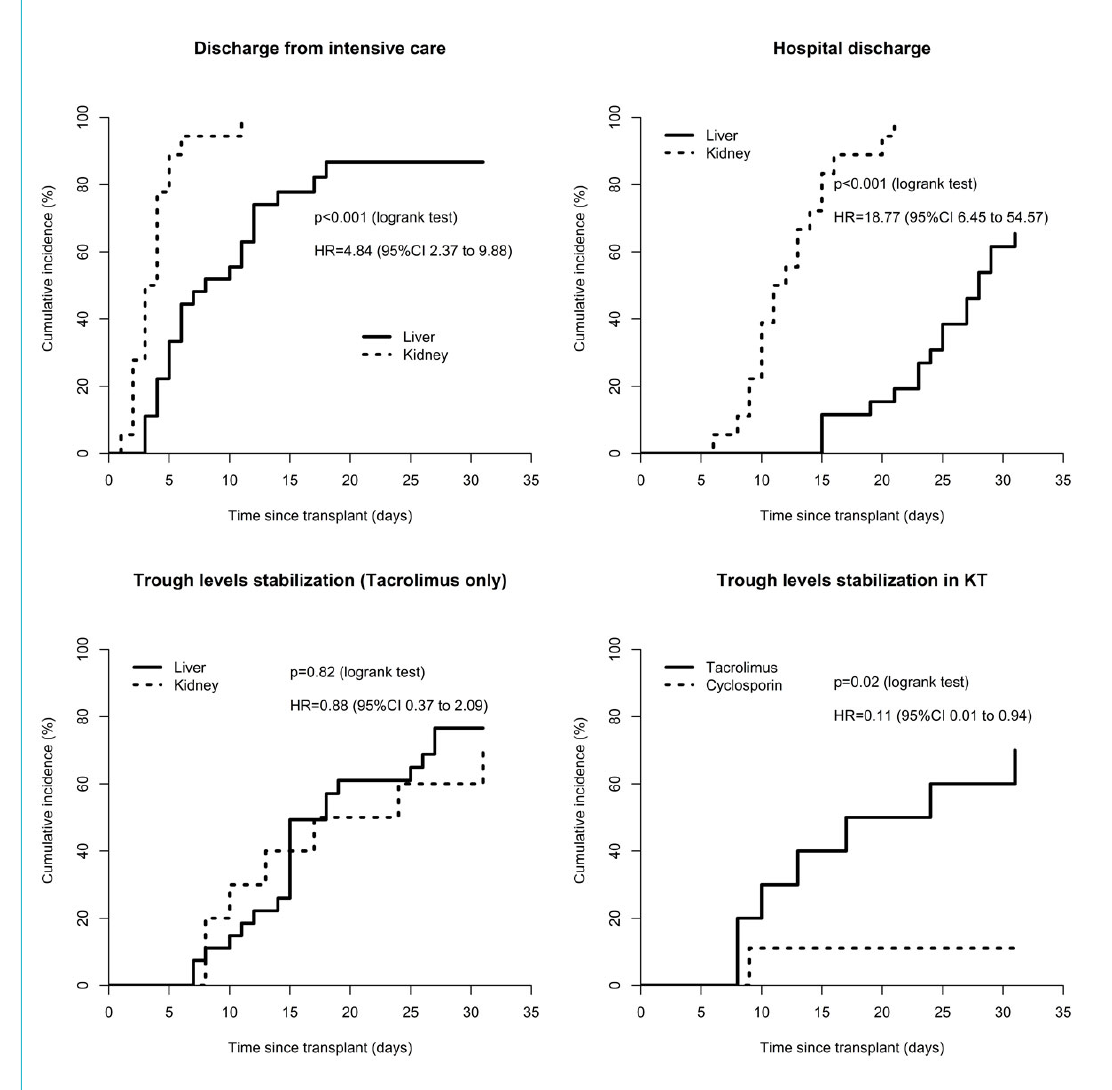
Figure 3: 30-day stabilisation cumulative incidence in liver and kidney transplant recipients. CI = confidence interval; HR = hazard ratio; KT = kidney